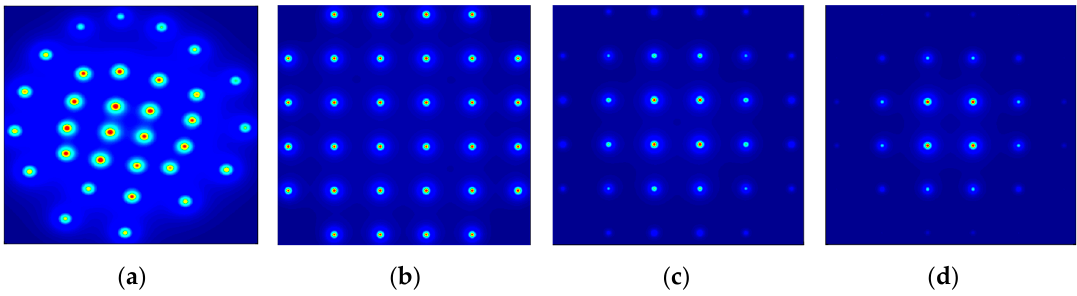
( d ) Figure 4. Huffman coding ( a ) and the constellation format ( b ) for 5-QAM; Huffman coding ( c ) and the constellation format ( d ) for 9-QAM. A more efficient and practical way to generate HPGS-QAM is based on universal probabilistic shaping scheme and GMI-optimized GS scheme [44,60]. Figure 5 shows the constellation formats for